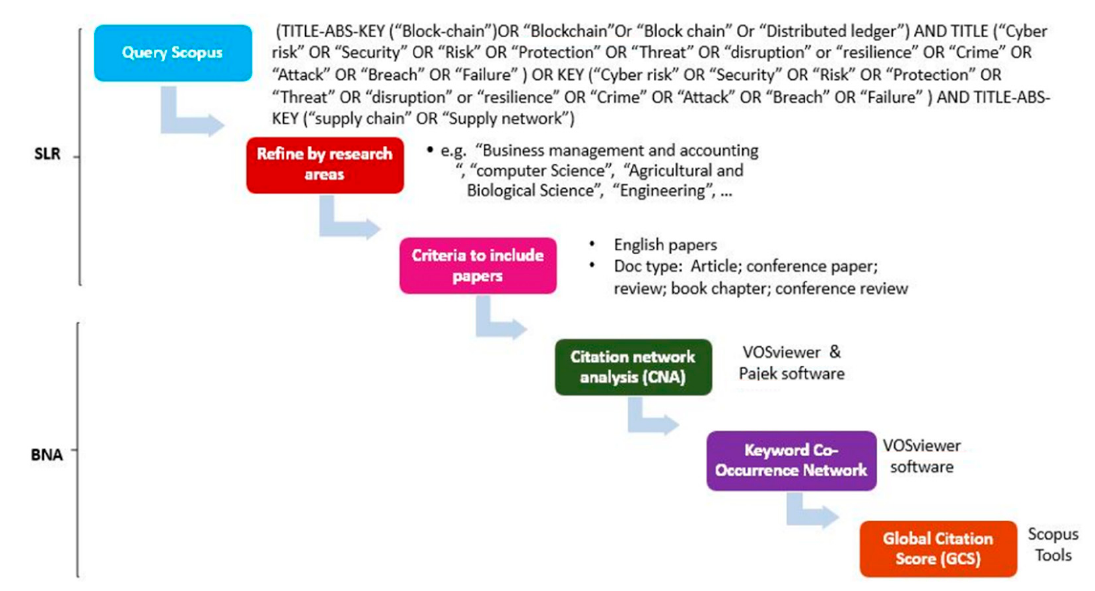
Figure 1. Systematic literature network analysis (SLNA).